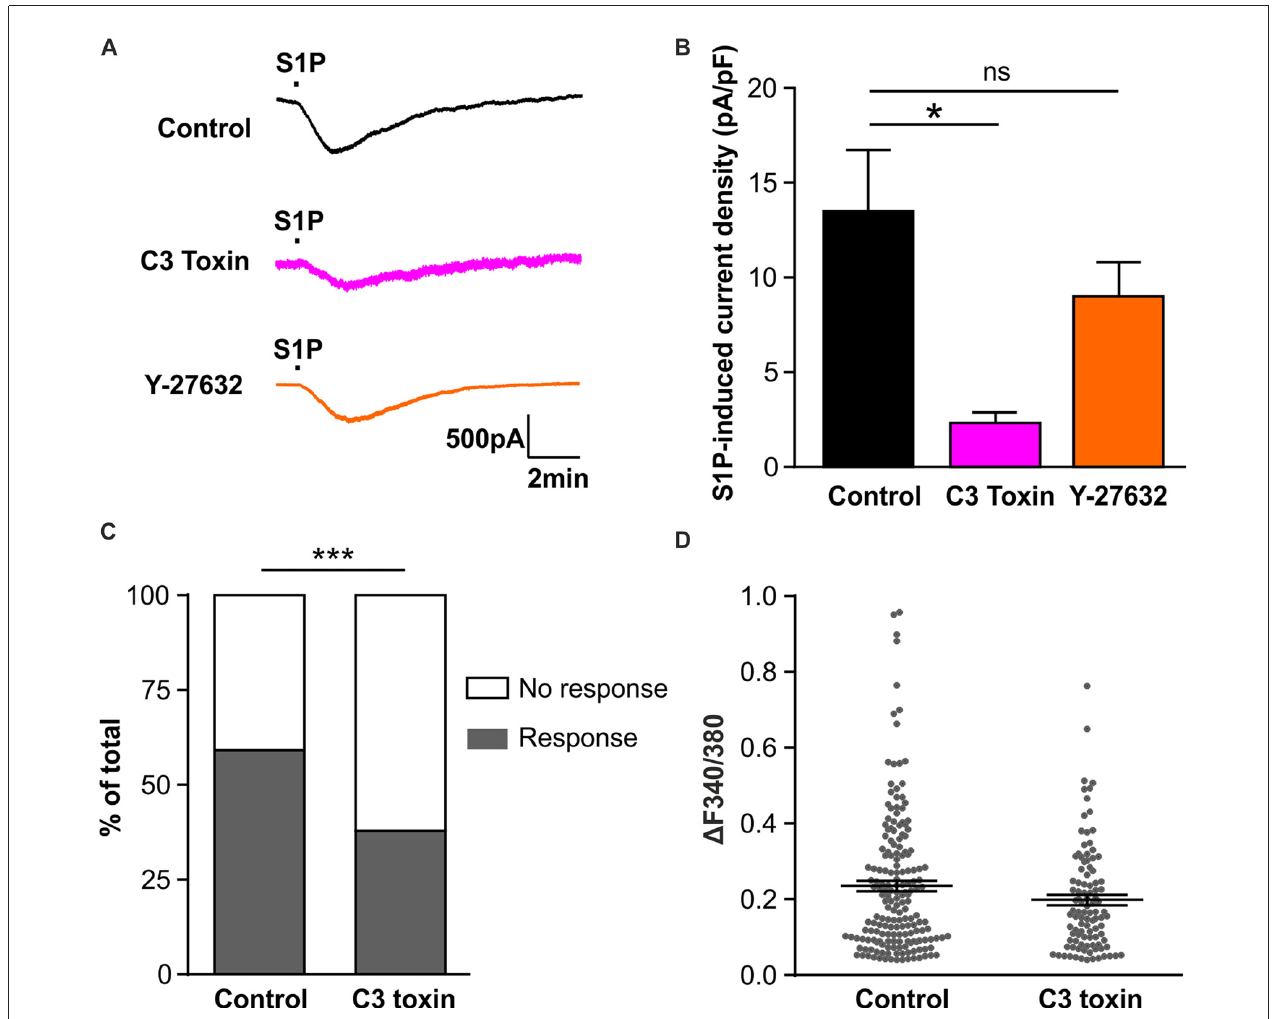
FIGURE 4 | Activation of Rho but not Rho-associated protein kinase (ROCK) is required for S1P-induced activation of a Cl − conductance in sensory neurons. (A) Example traces of inward current induced by 1 µ M S1P recorded under whole-cell voltage clamp conditions in cultured DRG neurons pretreated without (control) or with Rho inhibitor C3 toxin (0.5 µ g/ml, overnight) or ROCK inhibitor Y-27632 (10 µ M, 30 min) at − 80 mV holding potential. (B) Quantitative comparison of S1P-induced current density in control and drug-pretreated DRG neurons. Pretreatment with C3 toxin (0.5 µ g/ml, overnight) significantly reduced S1P-induced inward current in cultured sensory neurons (Unpaired t -test, n = 13–20, ∗ p < 0.05). No significant difference was obtained between control and Y-27632-pretreated group (Unpaired t -test, n = 14–20, p > 0.05). (C) Calcium imaging was used to record S1P-evoked Ca 2 + transients in control and C3 toxin-pretreated DRG neurons. Stacked histograms showing that pretreatment with Rho inhibitor C3 toxin (0.5 µ g/ml) significantly decreased the percentage of S1P-responding neurons (Fisher’s exact test, n = 273–306, ∗∗∗ p < 0.001). (D) The dot-plot graph showing no significant difference in S1P-evoked Ca 2 + increase magnitude between control and C3-toxin treated groups (Mann-Whitney U test, n = 103–180, p > 0.05). Each dot represents a single S1P-responding